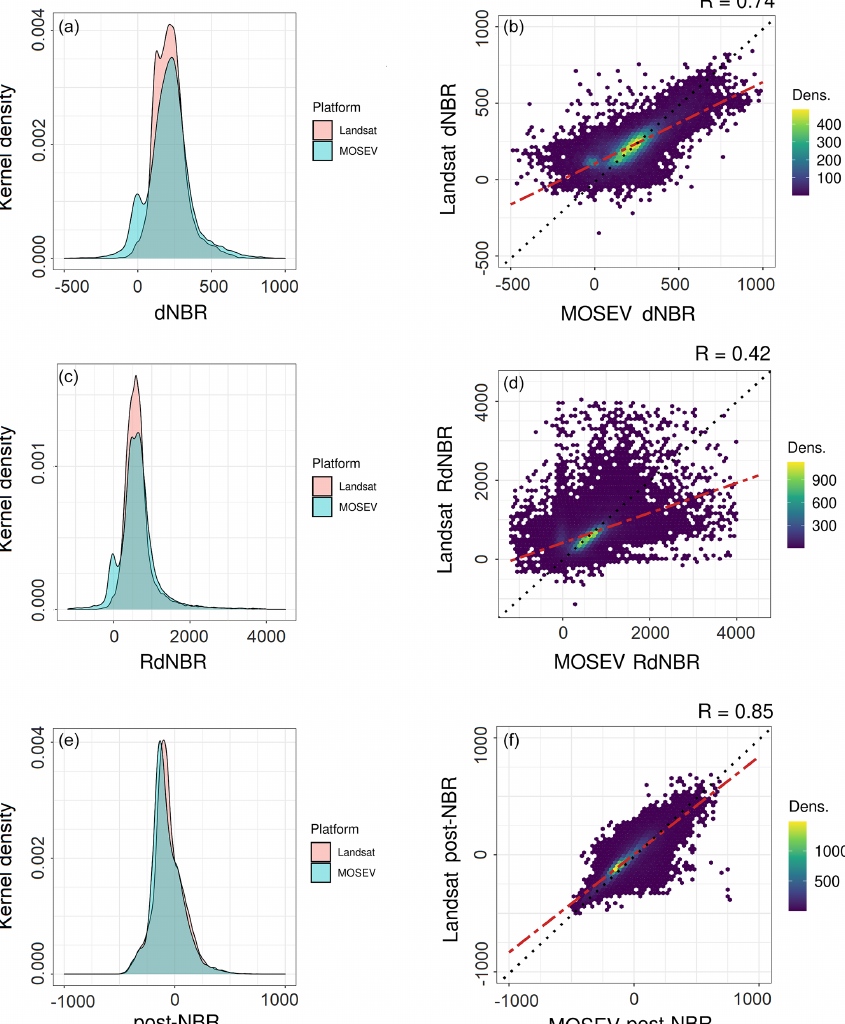
Figure 4. Gaussian kernel densities (a, c, e) and scatterplots (b, d, f) showing the relationships between the burn severity data included in the MOSEV database (dNBR, RdNBR and post-burn NBR spectral indices) and the equivalent data obtained from 13 Landsat-8 scenes randomly distributed across the globe ( n = 32163). R is Pearson’s correlation coefficient, and Dens. signifies density of points. See Table A1 for further